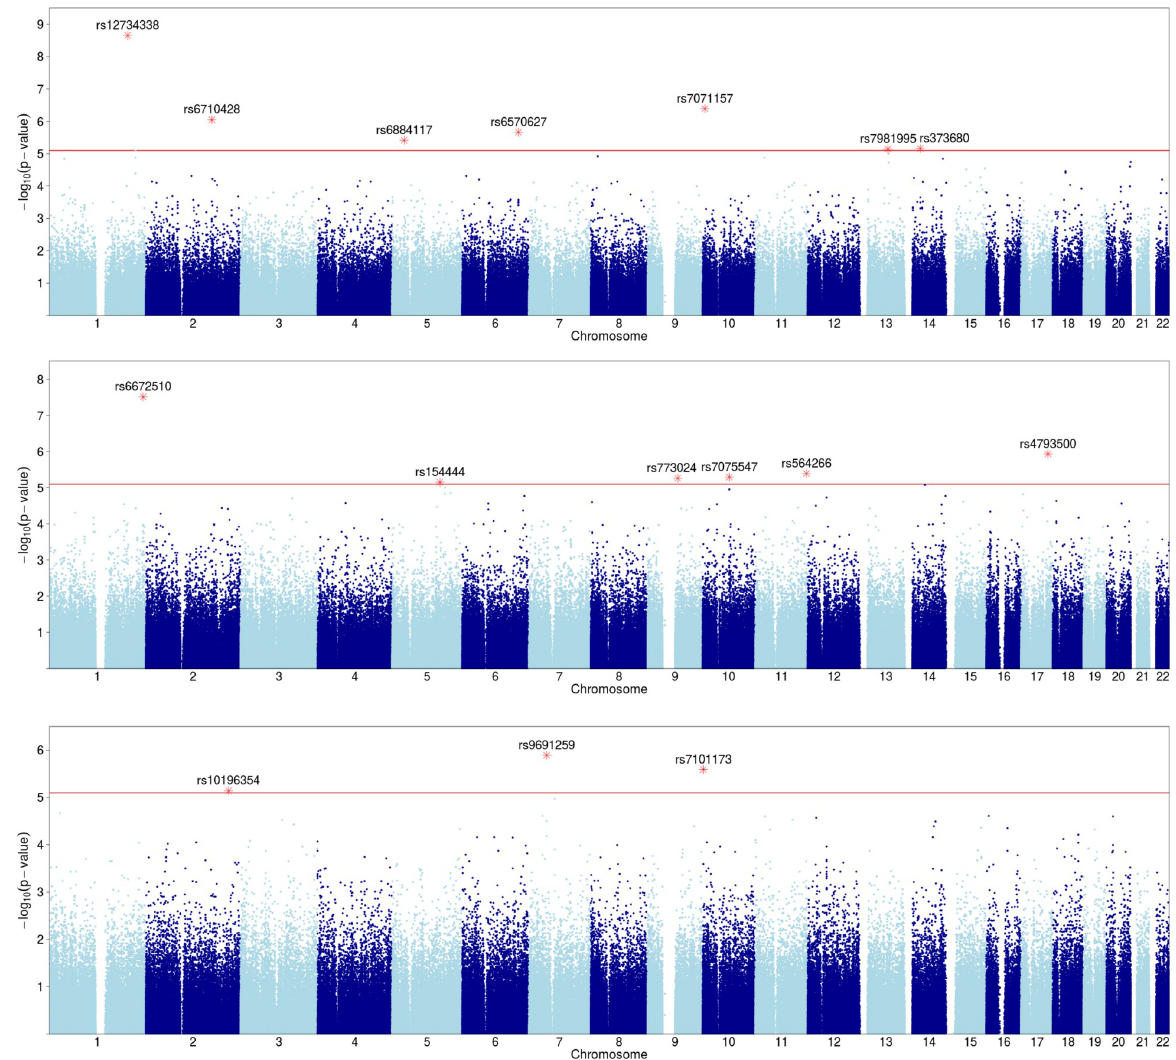
Fig 2. Manhattan plot of SNPs with growth parameter dependence. Y-axis shows p-values (negative log scale) of pairwise dependence of SNPs with three growth variables: a ) linf , b ) lambda , and c ) alpha . SNPs with p-value < 8x10 -6 (red line) are highlighted and